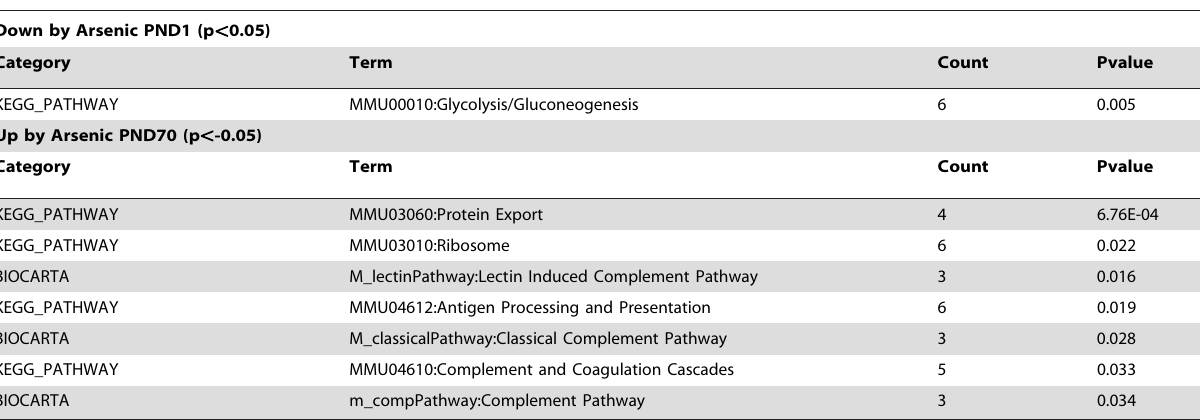
Table 3. Gene ontology of differentially expressed microRNA target mRNAs.